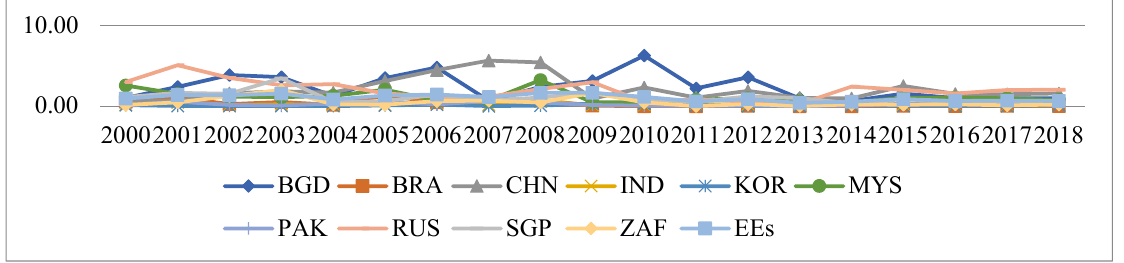
Figure 2. Yearly standard deviation (SD) of money market interest.